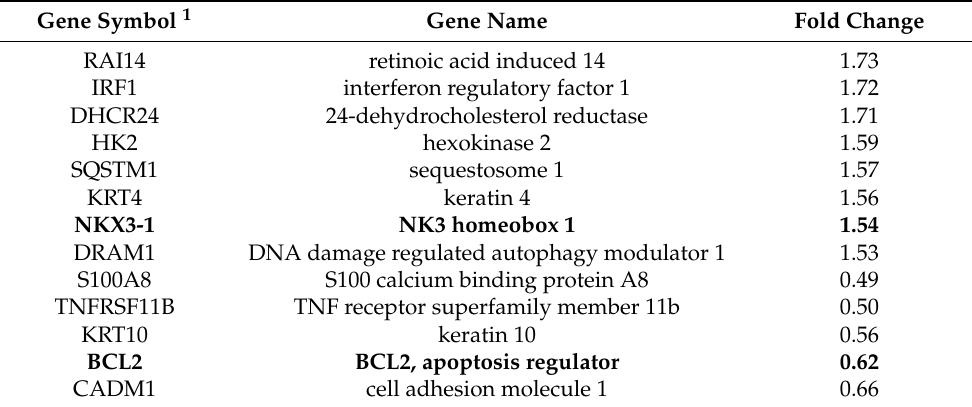
Table 3. List of cell-death-related genes differentially expressed only in MCF7-WT cells. Gene Symbol